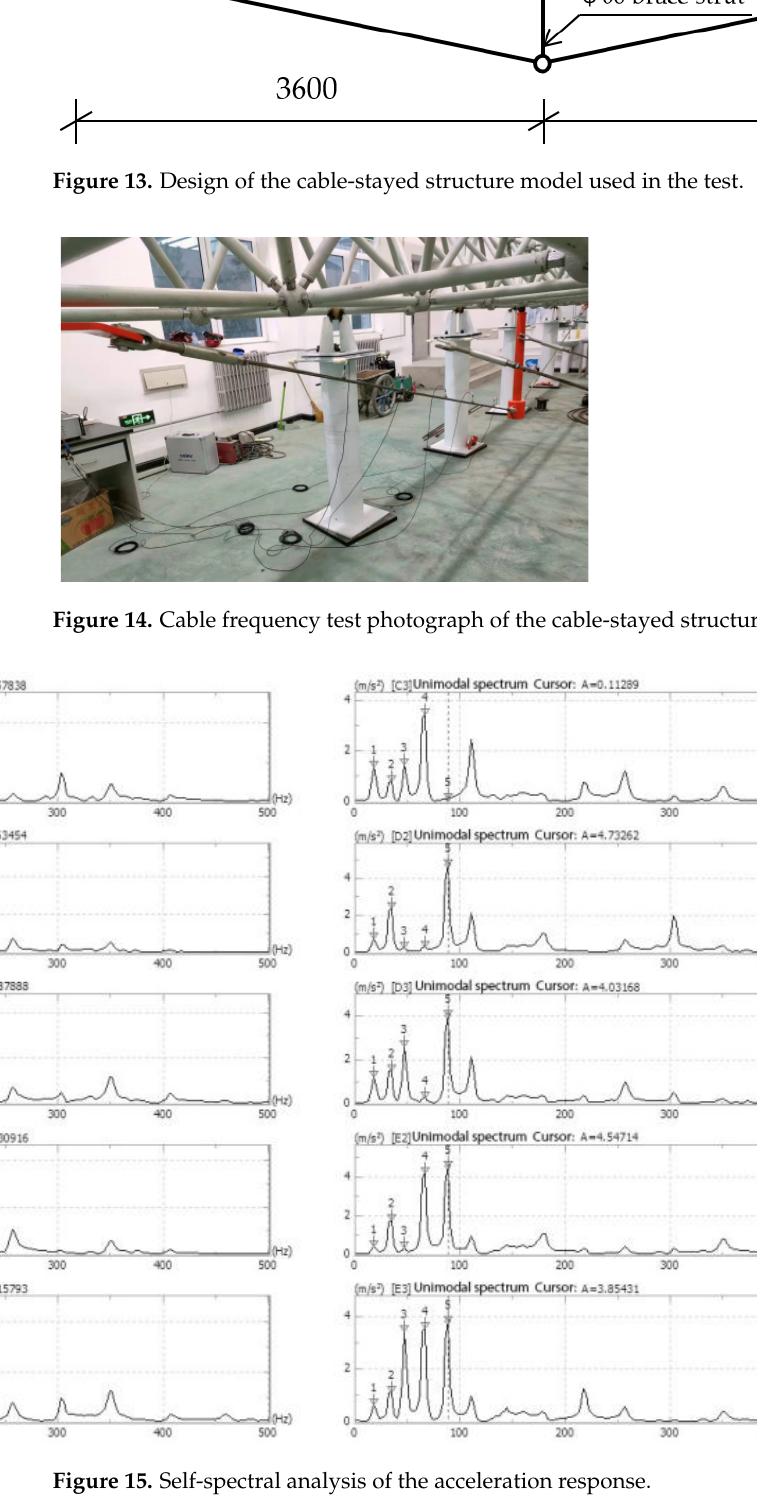
Table 3. Results of frequency detection and cable force calculation of a cable-stayed structure.